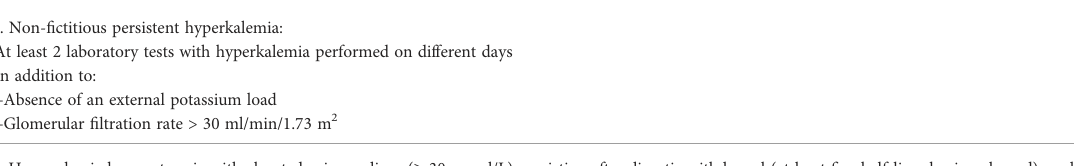
TABLE 1 Criteria used for diagnosis of